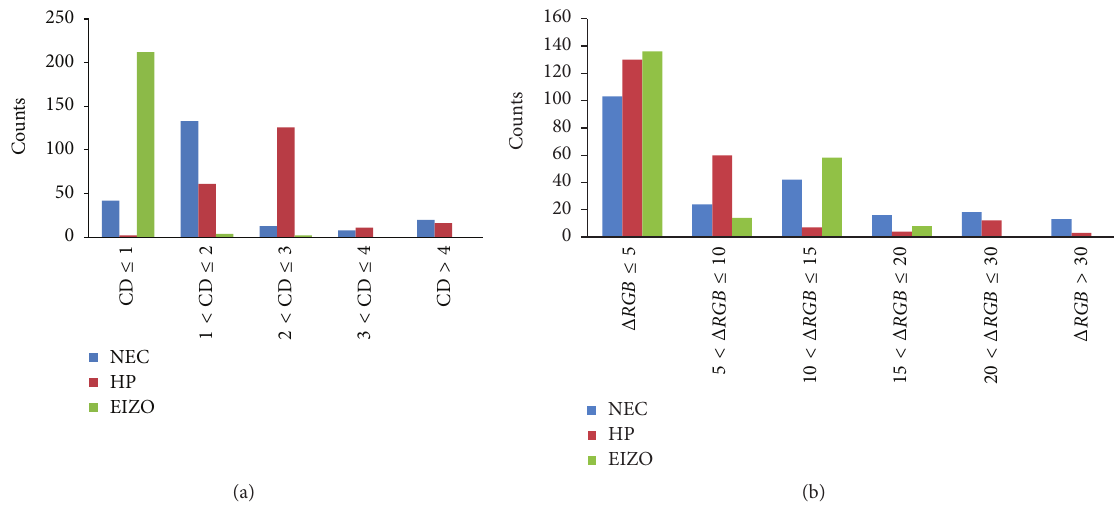
Figure 6: (a) Histogram of the color difference distribution of backward model and (b) histogram of Δ𝑅𝐺𝐵 distribution of backward